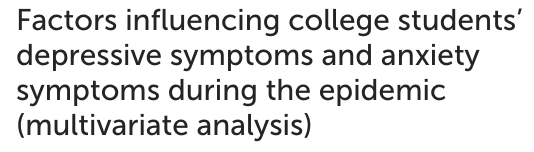
+ bM + e3; in model 1, the coefficient C was the total